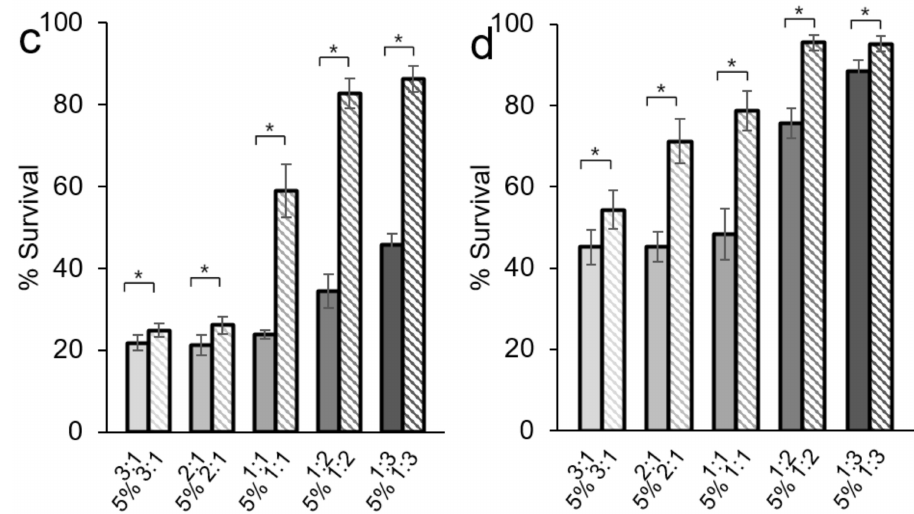
Figure 1. Percentage survival of cells treated with: ( a ) nonpolyethylene glycol (PEG)ylated 3:1, 2:1, 1:1, 1:2 and 1:3 Dc-chol/DOPE liposomes; ( b ) PEGylated 3:1, 2:1, 1:1, 1:2 and 1:3 Dc-chol/DOPE liposomes; ( c ) 5% PEGylated or nonPEGylated 3:1, 2:1, 1:1, 1:2 and 1:3 Dc-chol/DOPE liposomes at 64 nM and ( d ) 5% PEGylated or nonPEGylated 3:1, 2:1, 1:1, 1:2 and 1:3 Dc-chol/DOPE liposomes at lipid concentrations of 32 nM for 72 h. Data represented as mean ± SD ( n = 4). Statistically significant ( p < 0.05) differences are shown as *.